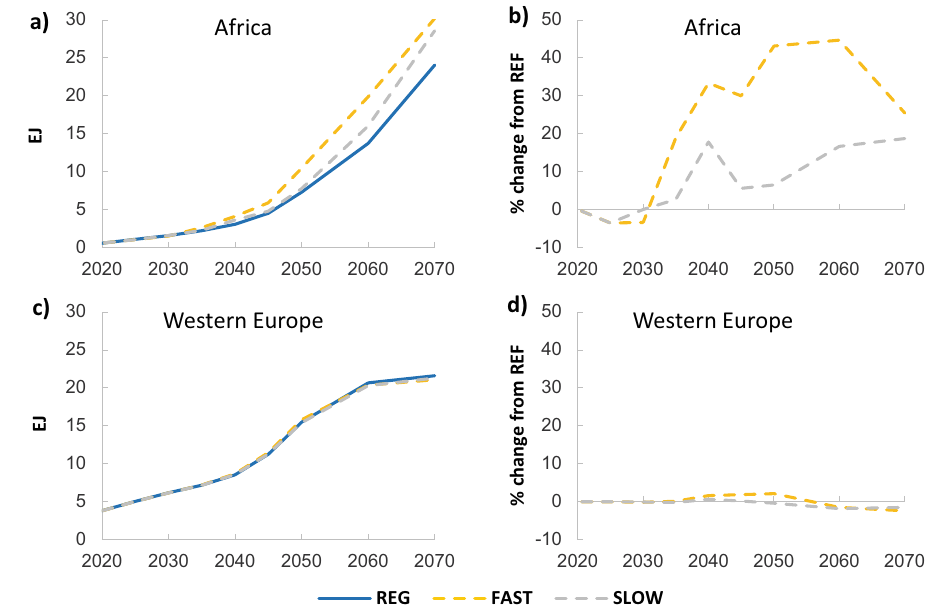
Fig. 4 Low-carbon electricity generation and percentage changes compared to the REG scenario. The left hand panels show low-carbon electricity generation in EJ for ( a ) Africa and ( c ) Western Europe, while the right hand panels show the percentage change in generation compared to the REG scenario for ( b ) Africa and ( d ) Western Europe. Investment is constrained to NDCs until 2030 hence impacts of changed fi nancing only emerge after